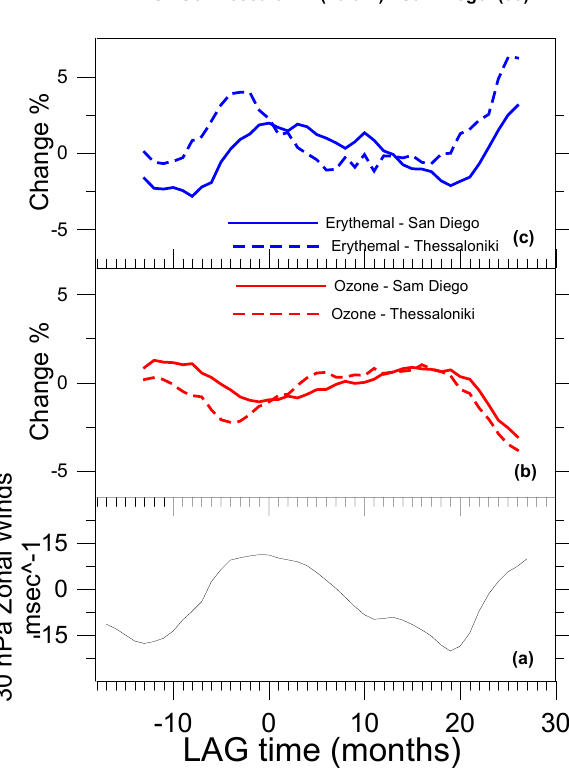
Fig. 4. Composites of (a) 30 hPa zonal wind at Singapore, (b) total ozone at San Diego and Thessaloniki and (c) daily erythemal ex- posure at San Diego and Thessaloniki. The composites have been calculated from TOMS measurements for seven QBO cycles (1980– 1995).